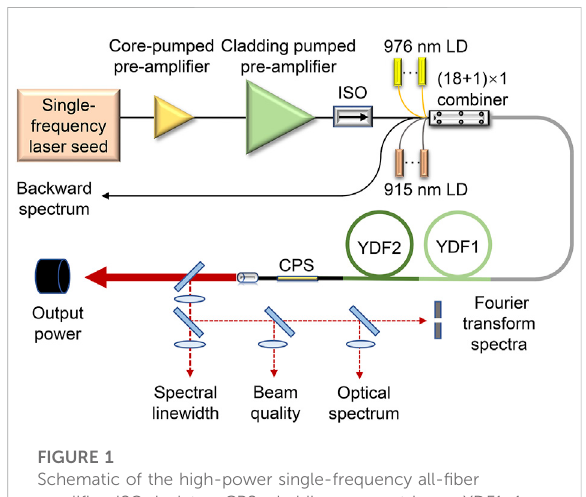
FIGURE 1 Schematic of the high-power single-frequency all- fi ber ampli fi er. ISO: isolator; CPS: cladding pump stripper; YDF1: 1-m low Yb 3+ -doped fi ber with a 976-nm absorption coef fi cient